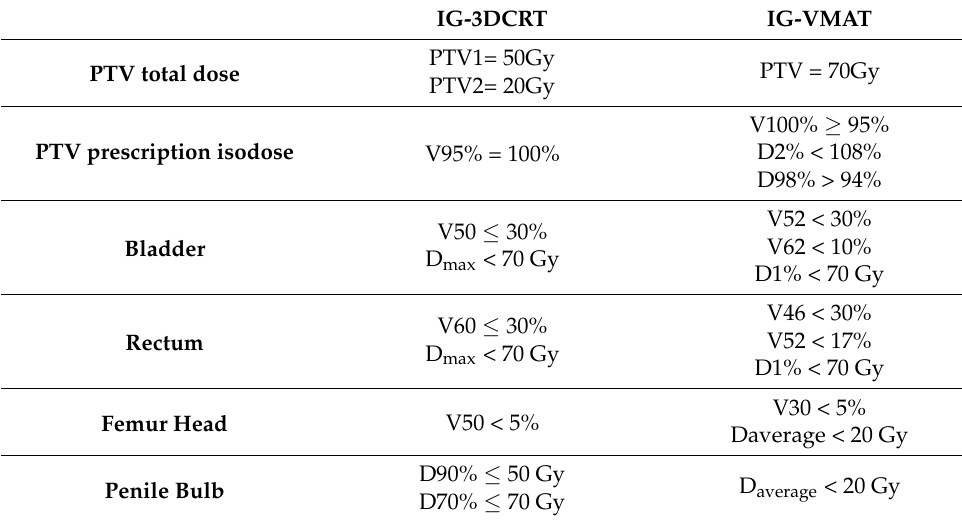
Table 2. Treatment characteristics and dose constraints.